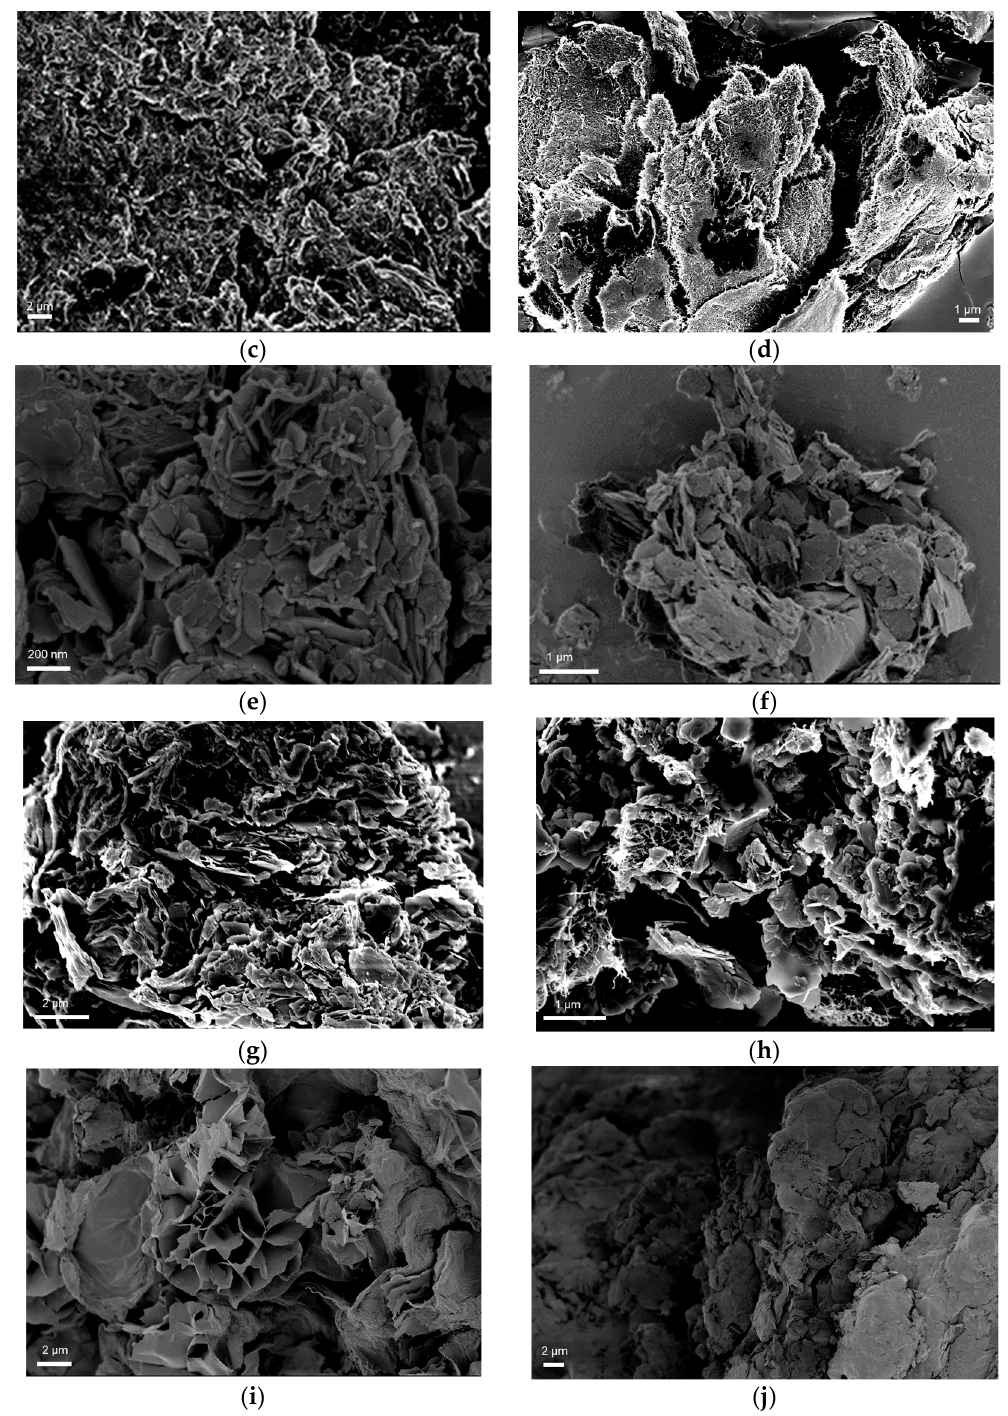
Figure 1. SEM images of: ( a ) unmodified Cu 3 (PO 4 ) 2 CaLB-HNFs; ( b ) unmodified Mn 3 (PO 4 ) 2 CaLB-HNFs; ( c ) GO-Cu 3 (PO 4 ) 2 CaLB-HNFs; ( d ) CNTs-Cu 3 (PO 4 ) 2 CaLB-HNFs; ( e ) GO/CNTs-Cu 3 (PO 4 ) 2 CaLB-HNFs; ( f ) GO/Fe 2 O 3 -Cu 3 (PO 4 ) 2 CaLB-HNFs; ( g ) GO-Mn 3 (PO 4 ) 2 CaLB-HNFs; ( h ) CNTs-Mn 3 (PO 4 ) 2 CaLB-HNFs; ( i ) GO/CNTs-Mn 3 (PO 4 ) 2 CaLB-HNFs; and ( j ) GO/Fe 2 O 3 -Mn 3 (PO 4 ) 2 CaLB-HNFs.